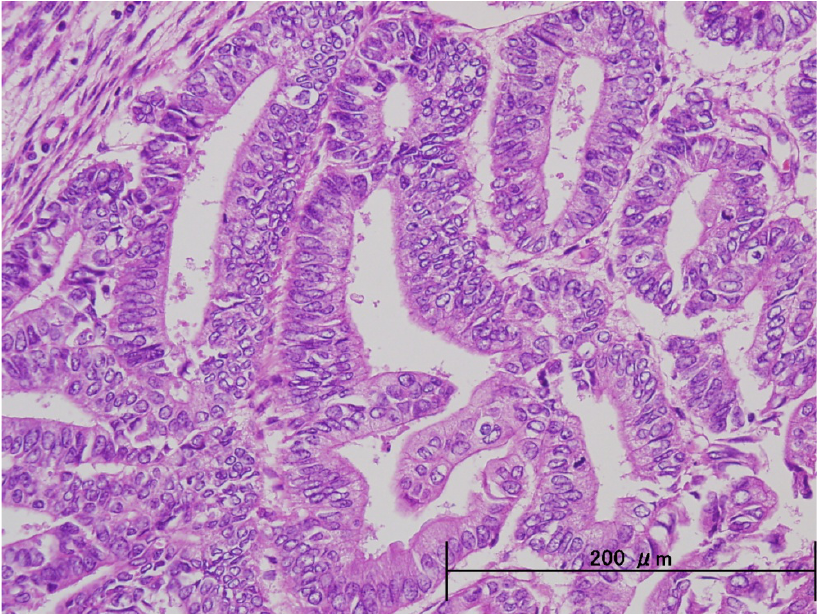
Figure 2. Endometrioid adenocarcinoma, grade 1. The glandular component is a caricature of proliferative phase glands, with stratification and shared luminal border to the neoplastic cells.